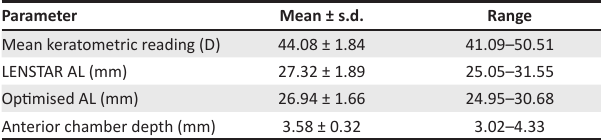
TABLE 1: Preoperative data.